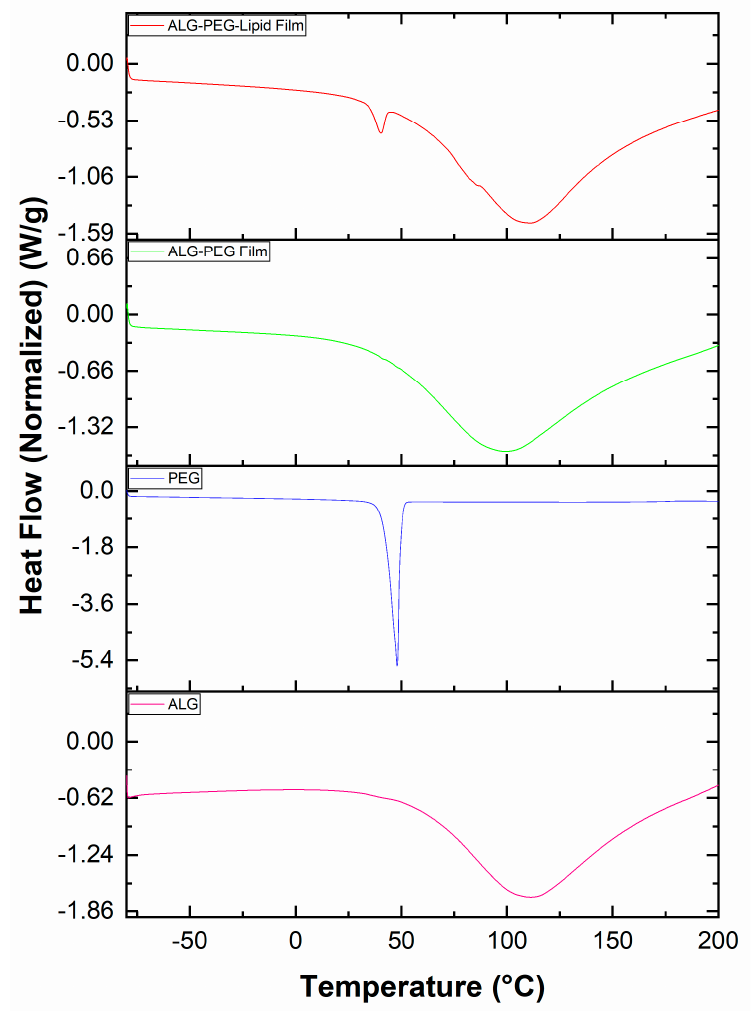
Figure 7. DSC spectra of the pristine sodium alginate and PEG-40S used, and the resultant alginate– PEG-40S and alginate–PEG-40S–phospholipid porous films obtained (alginate, PEG-40S, alginate–PEG-40S, and alginate–PEG-40S and phospholipid are denoted by ALG, PEG, ALG–PEG, and ALG–PEG–Lipid, respectively).